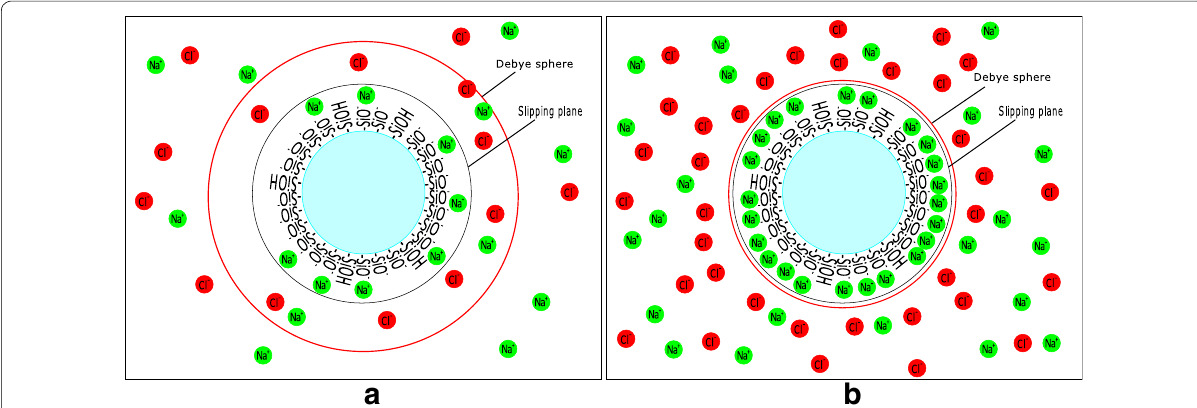
Fig. 2 Conceptual picture showing a single silica nanoparticle with a mostly dissociated surface surrounded by an alkali water solution. The sodium ions inside the slipping plane are completely locked in place and make up the stern layer. a Represents a particle dissolved in low concentrated NaCl solution and therefore have several unshielded SiO − surface groups. This particle retains most of its electrostatic repulsion forces which is shown by a large Debye sphere and is therefore either stable or will aggregate at a significantly slower rate than the particle shown in b . b Repre- sents a particle that is dissolved in a highly concentrated NaCl aqueous solution and is completely covered by sodium ions which leads to a greatly reduced Debye sphere. The b particle can be considered to be unstable i.e. it would aggregate with other particles